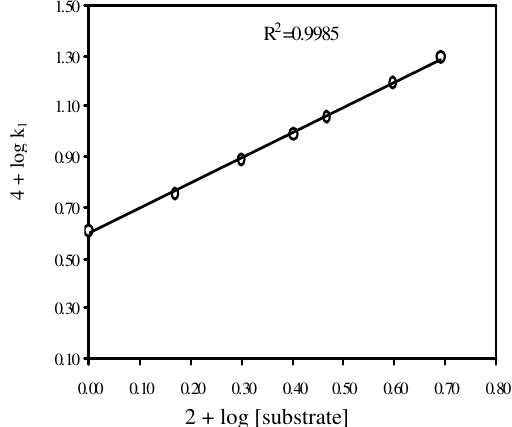
Figure 2. Variation of rate with substrate